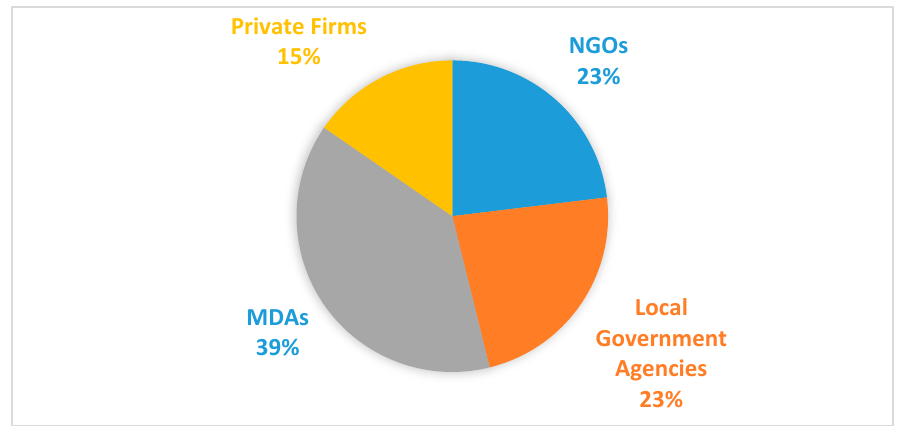
Figure 2. Key actors in Sustainable Energy Transition (SET) initiatives in the Wa municipality (Source: Authors’ calculations).